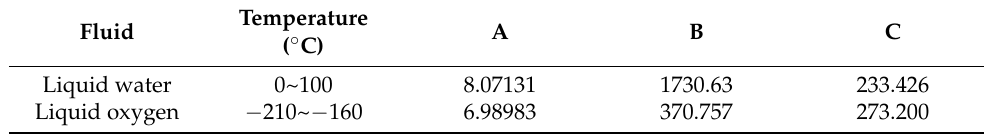
Table 1. Correlation constants of liquid water and liquid oxygen for the Antoine